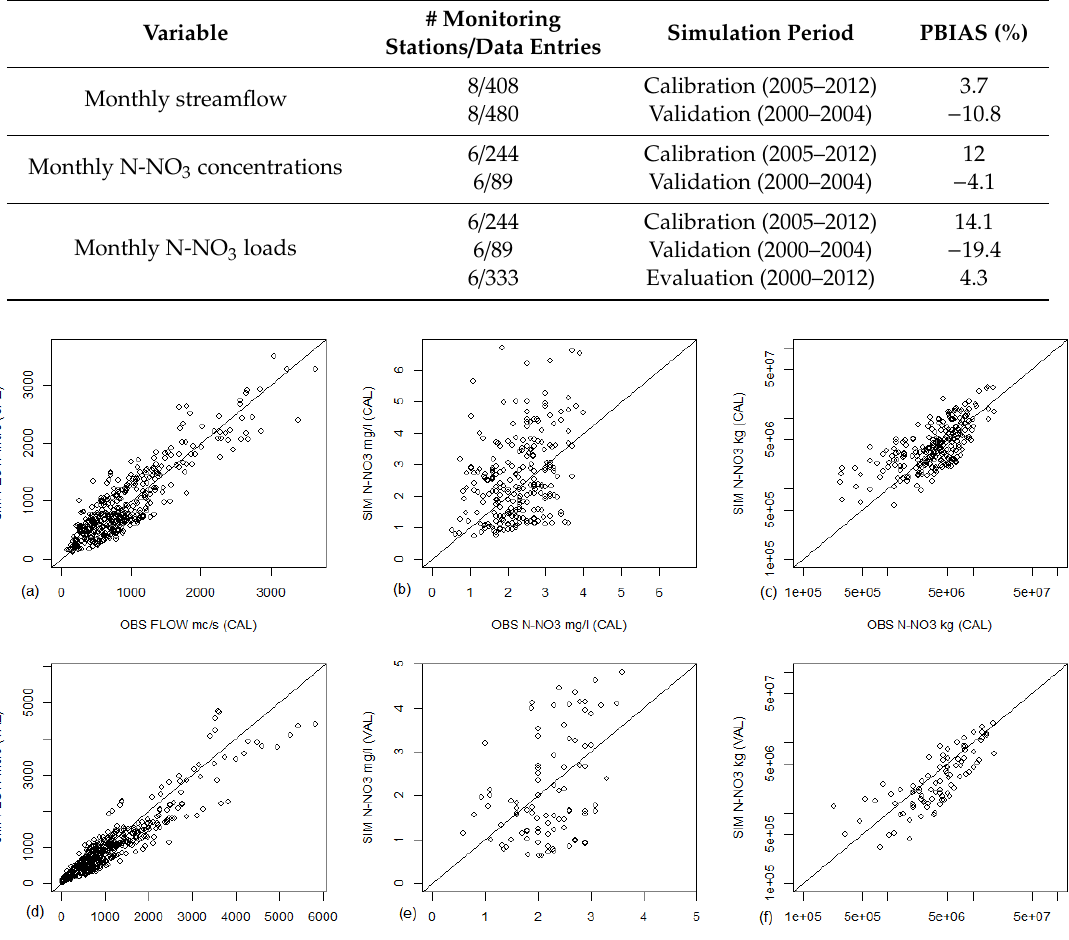
Table 7. Description of calibrated and validated variables (# = number; N-NO 3 = nitrogen nitrates) and model performance.